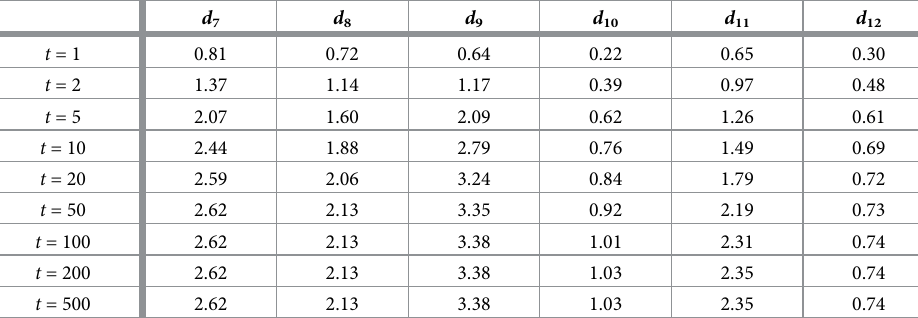
Table 3. The average queue size at time t for dropping functions d 7 − d 12 .